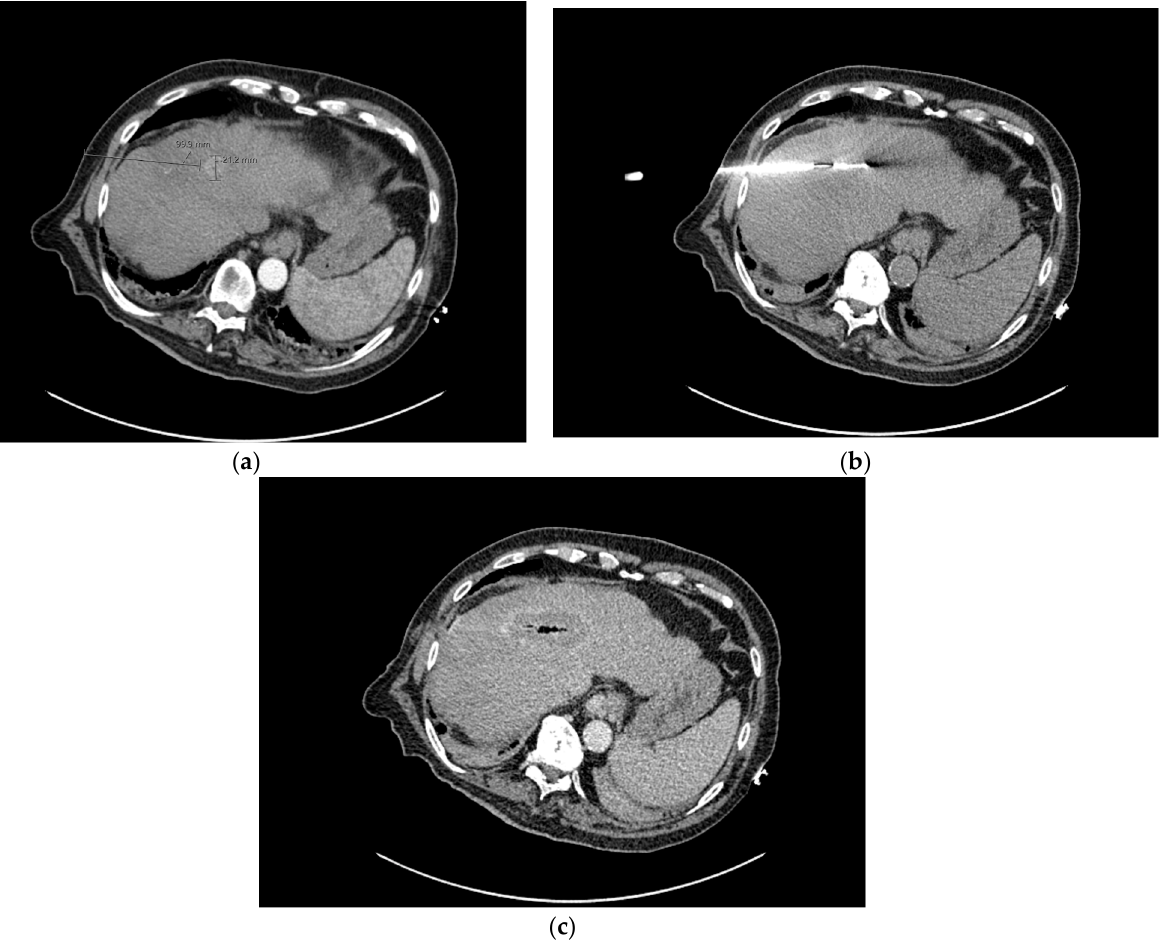
Figure 2. ( a ) Planning CT for microwave ablation of solitary hepatocellular carcinoma (Archive of Dr Fotiadis, The Royal Marsden Hospital). ( b ) Microwave ablation of solitary hepatocellular carcinoma (Archive of Dr Fotiadis, The Royal Marsden Hospital). ( c ) Post-ablation CT (Archive of Dr Fotiadis, The Royal Marsden Hospital).